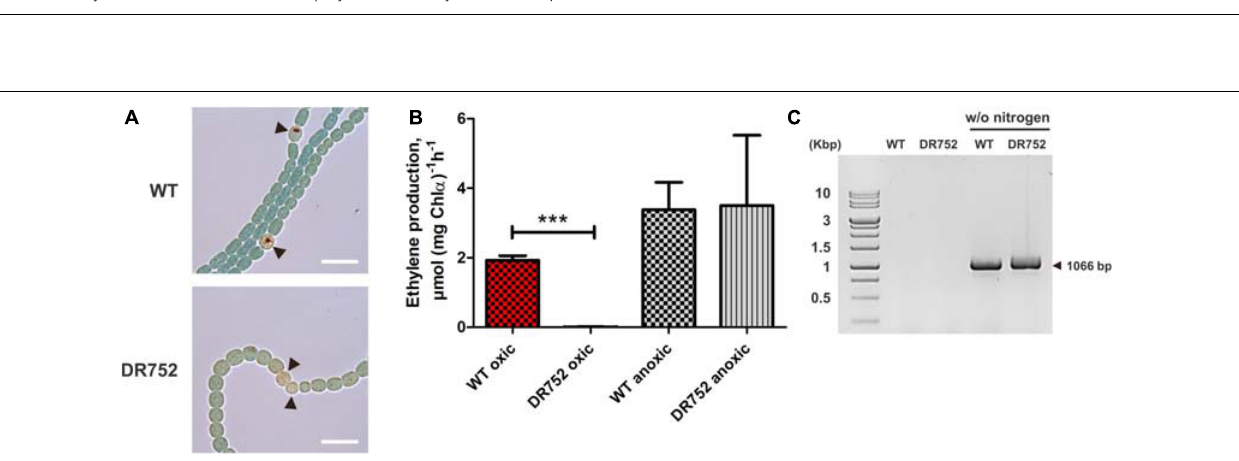
FIGURE 1 | Growth of the mutant strain DR752 and analysis of heterocyst-specific glycolipids in the envelope. (A) The growth of Anabaena variabilis wild type (WT) and DR752 mutant colonies on solid AA/4 medium (NO3 − ) and medium lacking a combined nitrogen source (N 2 ) after 7 days of incubation. (B) Thin-layer chromatography of lipid extracts from liquid cultures containing 50 µ g of chlorophyll before and after nitrogen step-down for 72 h; 1-WT with nitrate, 2-WT without nitrate, 3-DR752 with nitrate, 4-DR752 without nitrate. The arrow indicates the position of one heterocyst-specific glycolipid. (C) Transmission electron micrographs of terminal heterocysts of WT and mutant DR752. The lower panels show the magnified view of the envelope, indicated by squares. Black arrow points toward the laminated layer and star indicates the exopolysaccharide layer. Bars, 0.5 µ m.